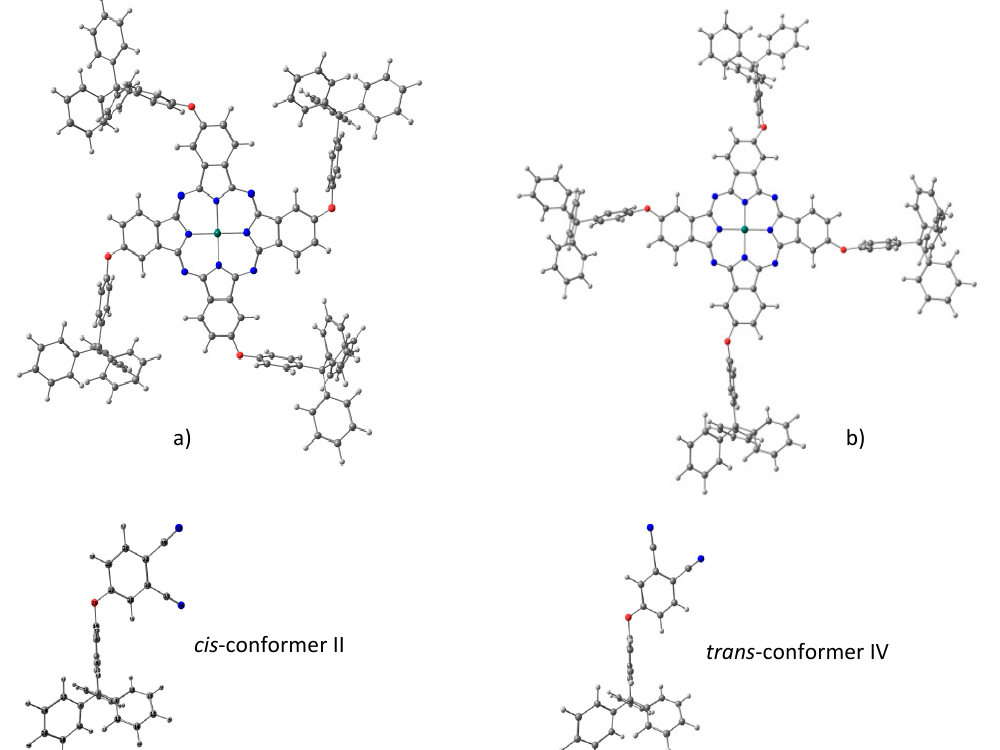
Figure 11. Tetra- cis -4-tritylphenoxy substituted metal phthalocyanines ( a ), tetra- trans -substituted metal phthalocyanines ( b ), bottom: cis - and trans -conformers of TPPN. A series of copper (4-tritylphenoxy)phthalocyanines was synthesized in [4].